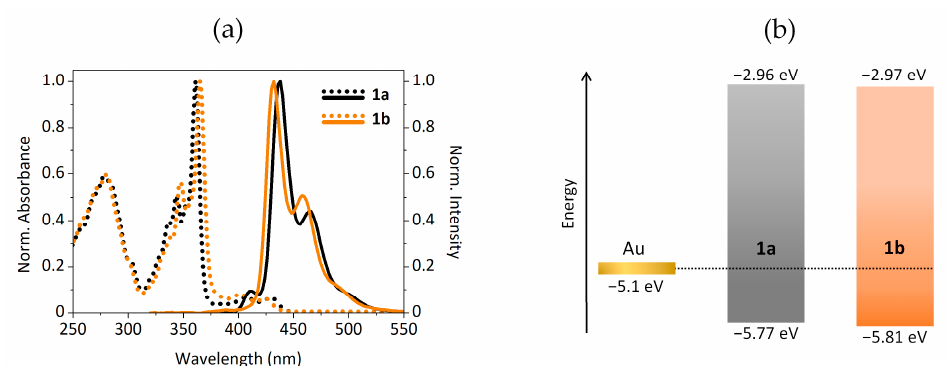
Figure 4. ( a ) Absorption (dotted) and emission (solid, λ ex = 300 nm) spectra of compounds 1a – b . ( b ) Energy levels of compounds 1a – b with respect to the gold electrodes.